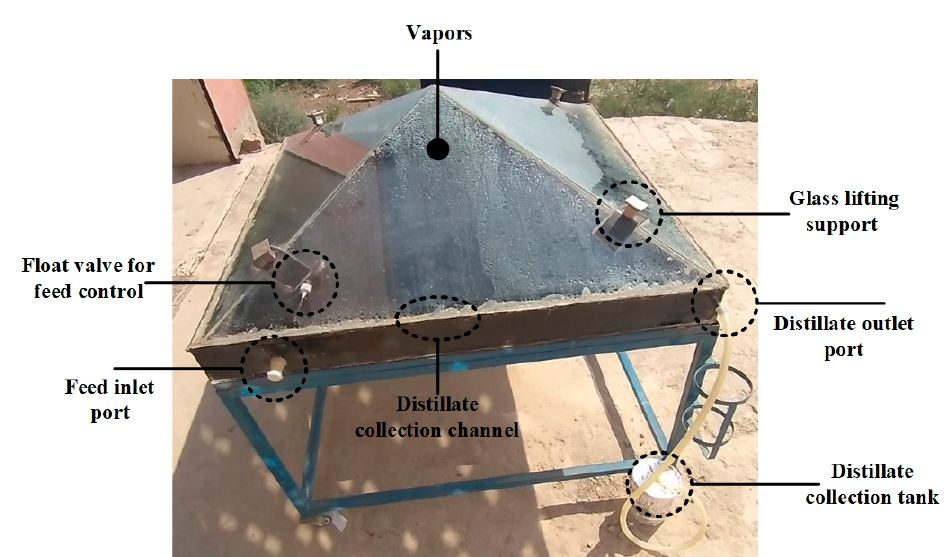
Figure 5. Pyramid shape solar still experimental setup.